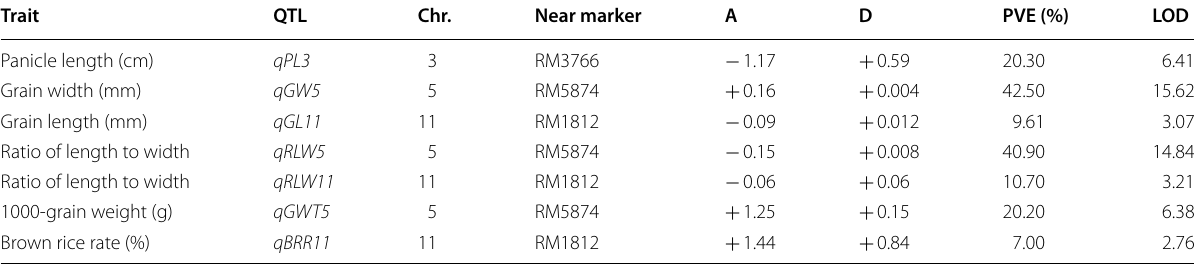
indicates that allele from Huhan3 substitution segment of Z414 increases the trait value, and + trait value. PVE indicates phenotypic variance explained